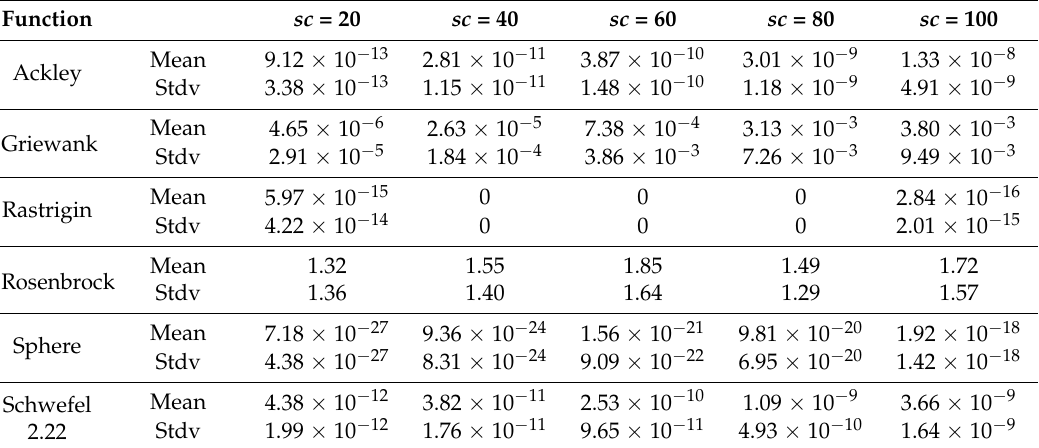
Table 5. The effect of sc on the means and standard deviations.